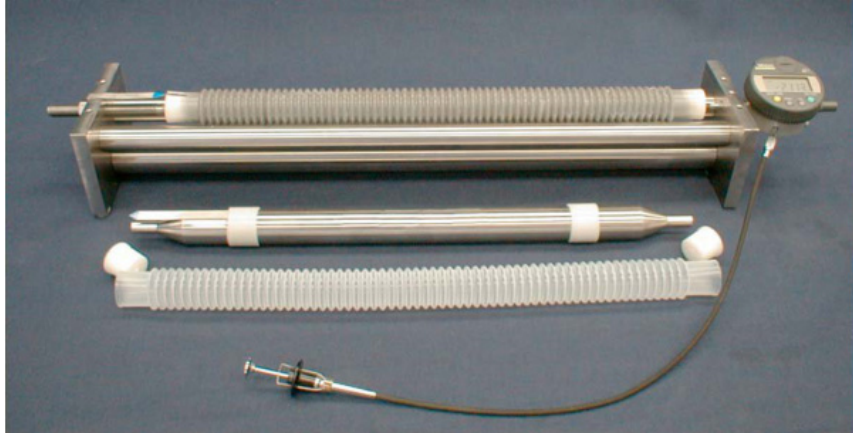
Figure 3. Schematic diagram of autogenous shrinking instrument [39].